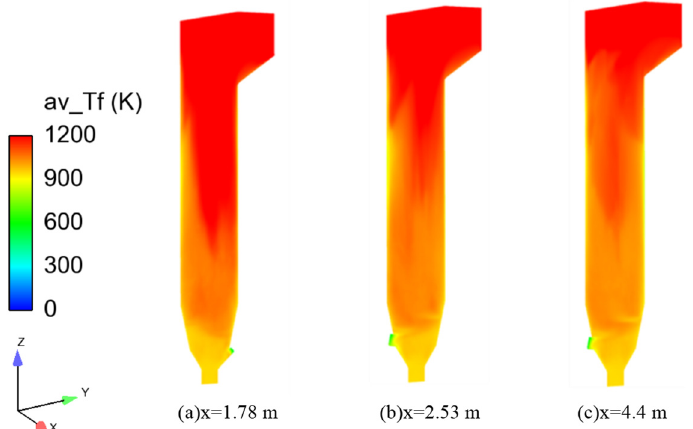
Figure 7. Contours of gas temperature distributions at key vertical sections in Case 1 (( a ) − returning port; ( b ) − secondary air port; ( c ) − fuel-feeding port; ( b ) − secondary air port; ( c ) − fuel-feeding port).